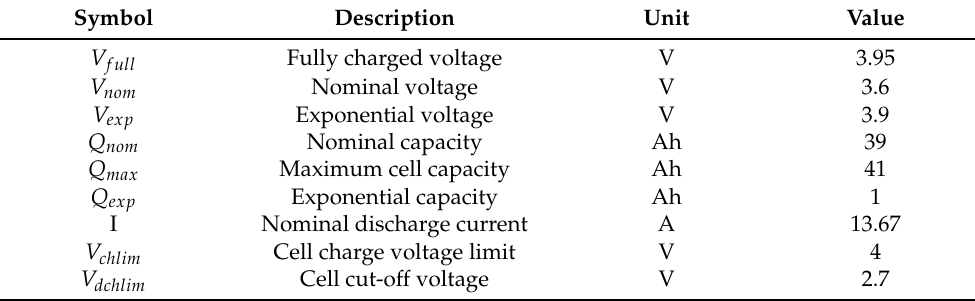
Table 1. Cell parameters values.